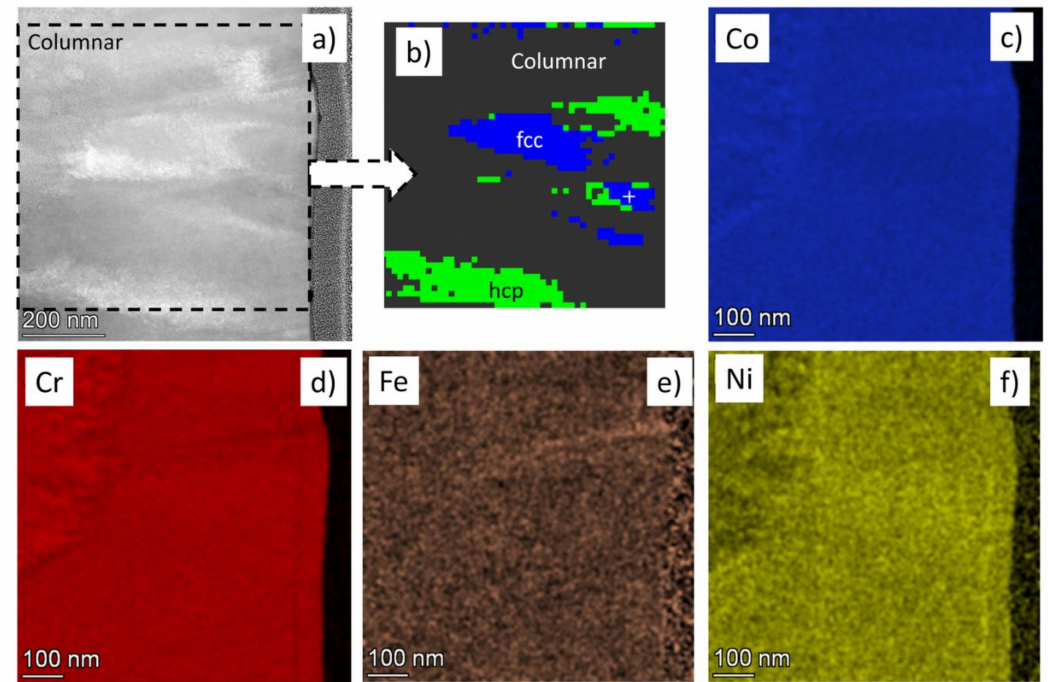
Figure 8. ( a ) HAADF image showing a magnified part of the layer in the columnar region at point No. 9. A phase map taken on this part of the sample can be seen in ( b ). The grey parts in ( b ) indicate areas where the phase identification was uncertain, while the green and blue regions are grains with hcp and fcc structures, respectively. The corresponding element maps for the four constituents are shown in ( c – f ).